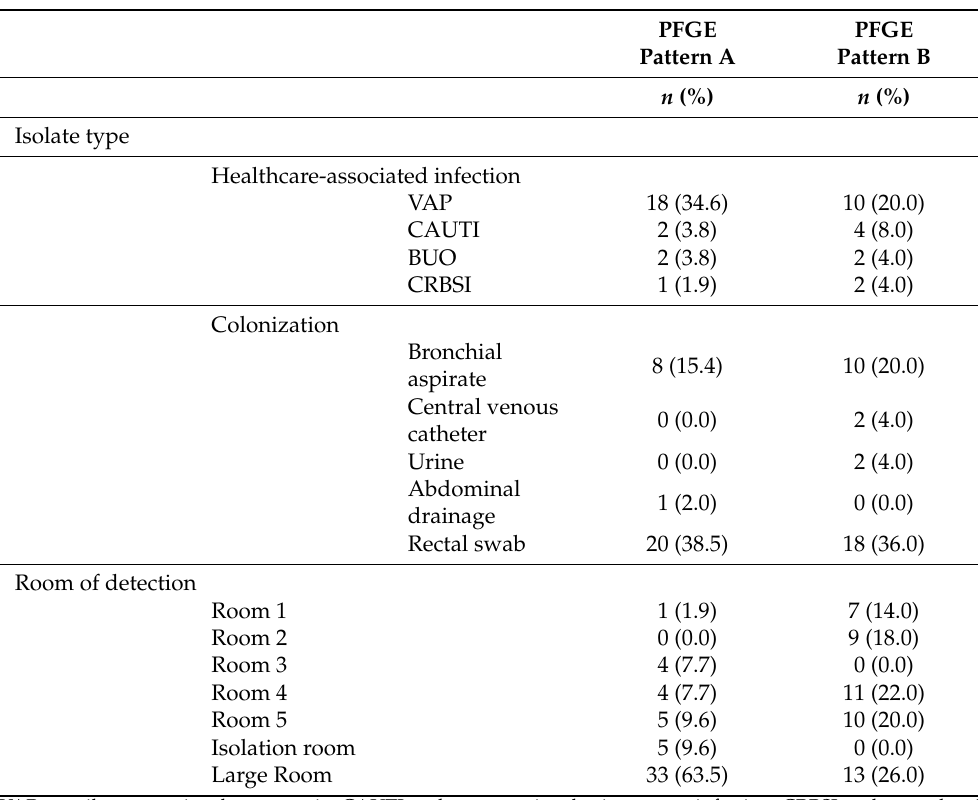
Table 1. Characteristics of the genotyped A. baumannii strains isolated by major pulsed-field gel electrophoresis (PFGE) pattern from SARS-CoV-2 patients admitted to the intensive care unit of the Umberto I teaching hospital of Rome between 1 March 2020 and 28 February 2021. Results are expressed as number and